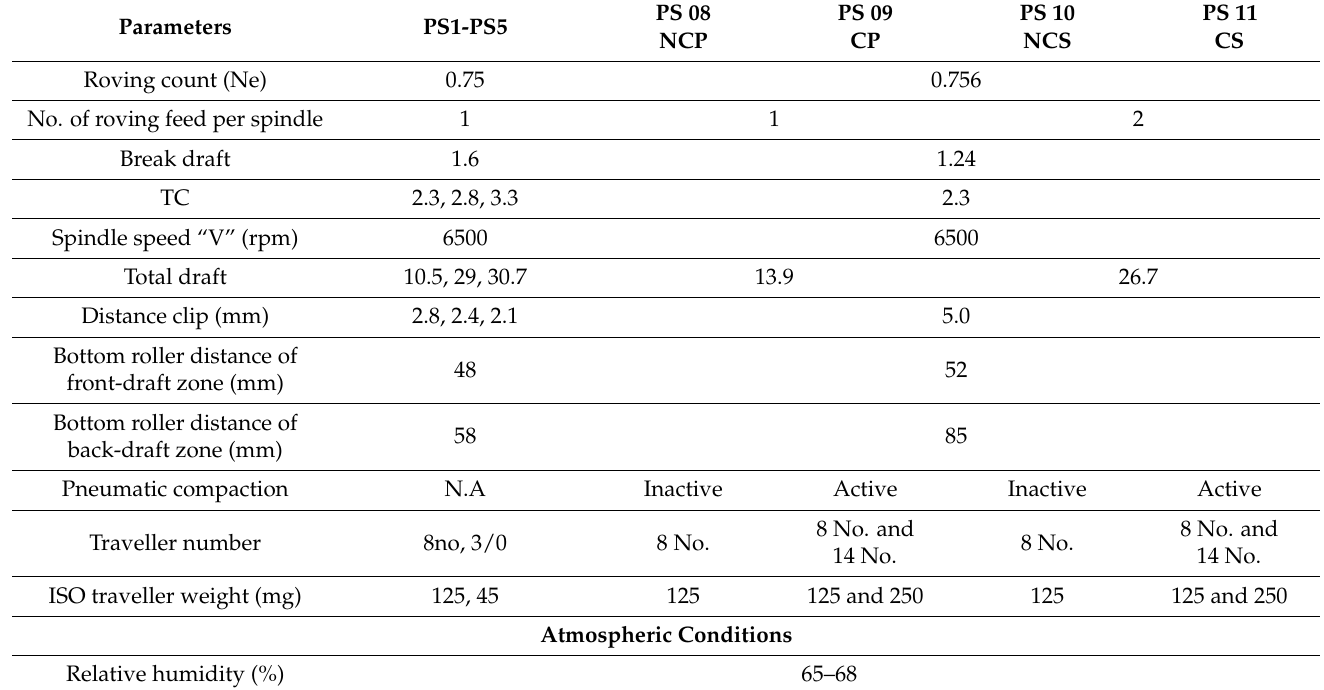
Table 4. Process parameters of conventional ring spinning and